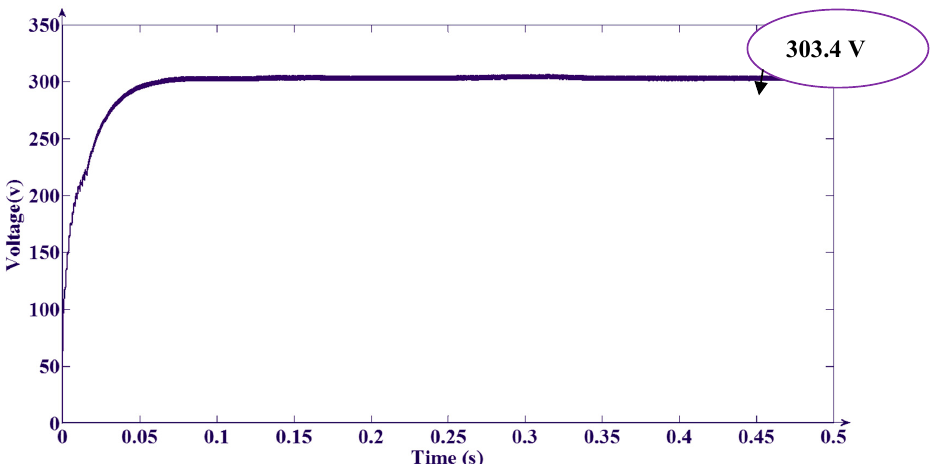
Figure 49. Output voltage waveform for hybrid controller-3-based BDC.